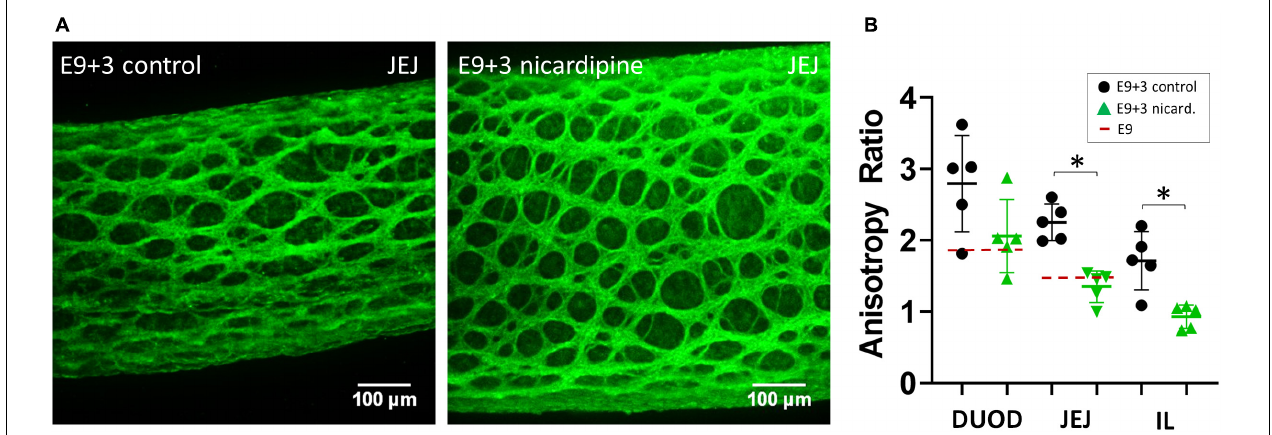
FIGURE 4 | Nicardipine inhibits longitudinal anisotropic growth of the ENS. (A) Representative Tuj1 immunostaining (max z-projection of stack) for control (vehicle only) samples and nicardipine treated samples after 3 days in culture (E9 + 3). DUOD, duodenum; JEJ, jejunum; IL, ileum. (B) ENS aspect ratio of control and nicardipine treated samples. Each dot is the average of the aspect ratio of 5–7 inter-ganglionic spaces from a different gut (different embryo). The dashed red line indicates the aspect ratio at E9. ∗ : statistically significant difference, Mann-Whitney two-tailed test, p <